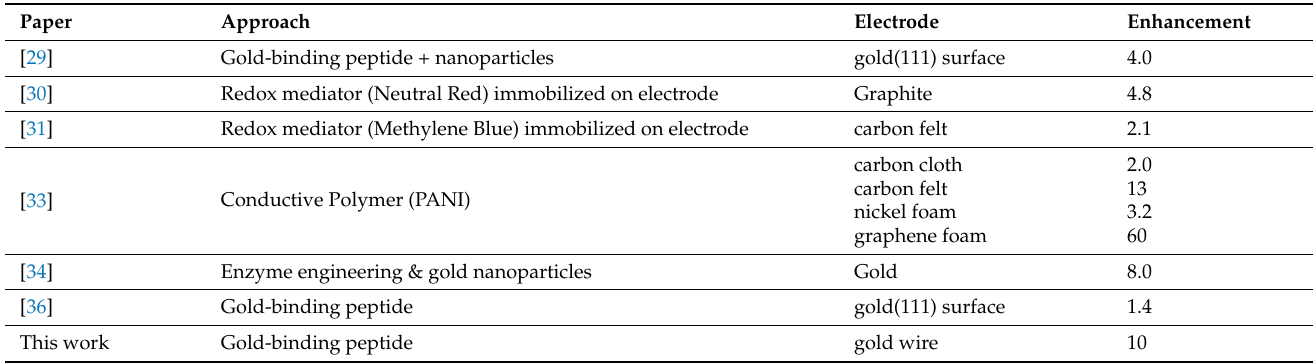
Table 1. Comparison of the power density increase for the best results in this work with some previous efforts.